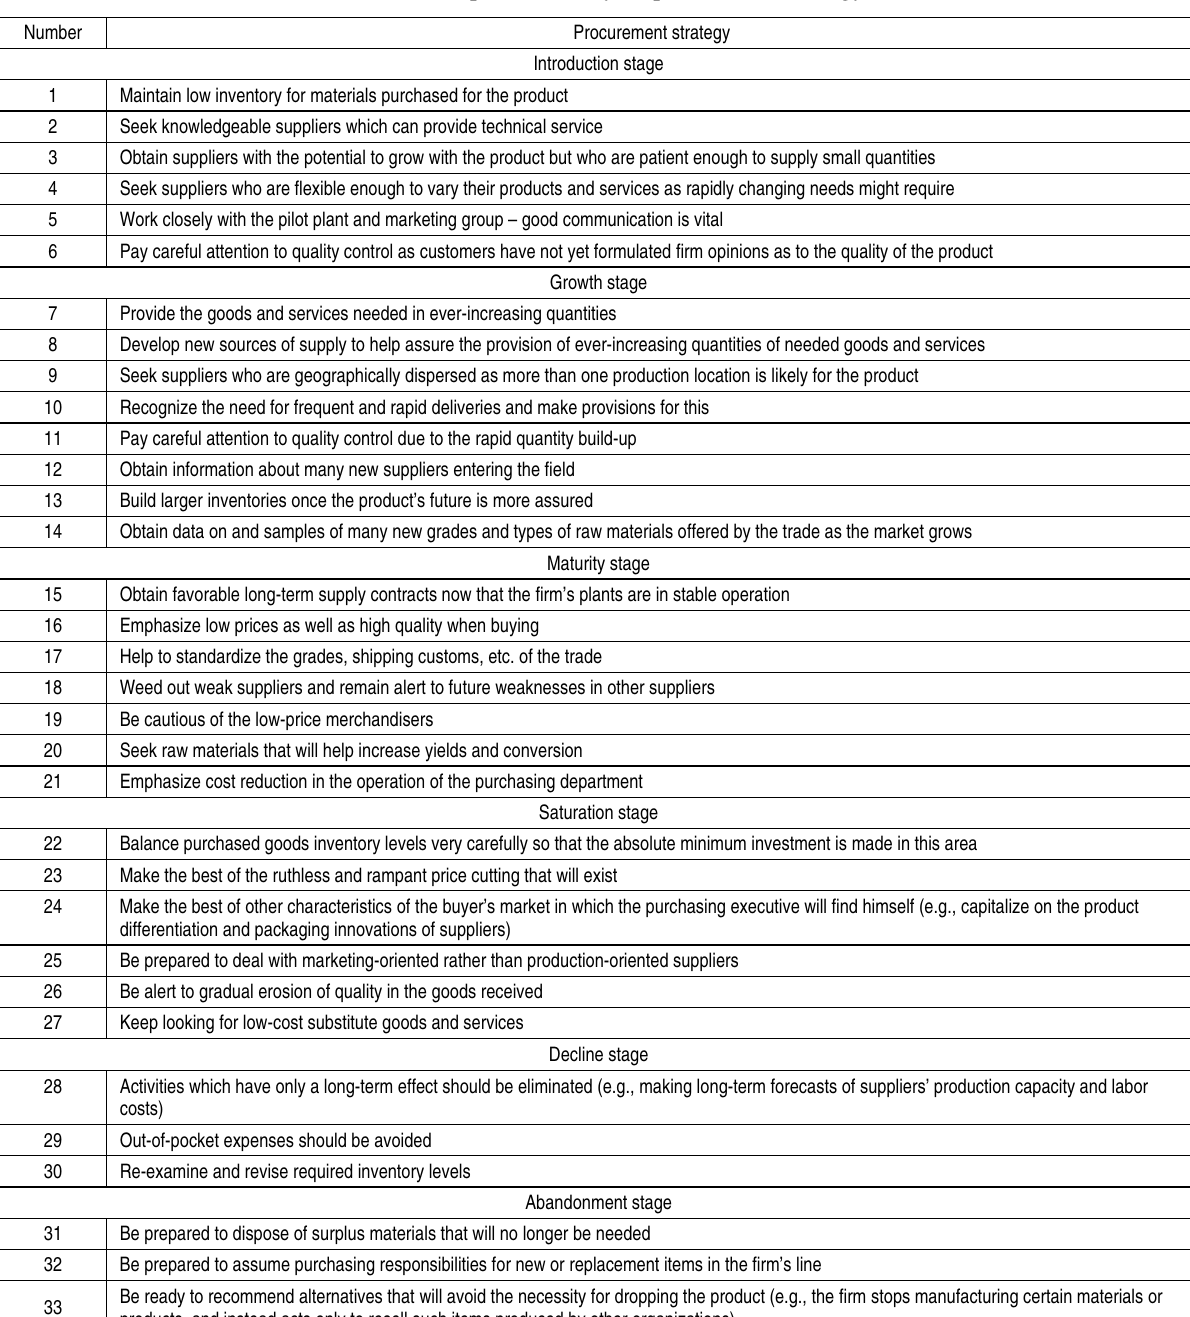
Table 2. Berenson’s product life cycle-procurement strategy